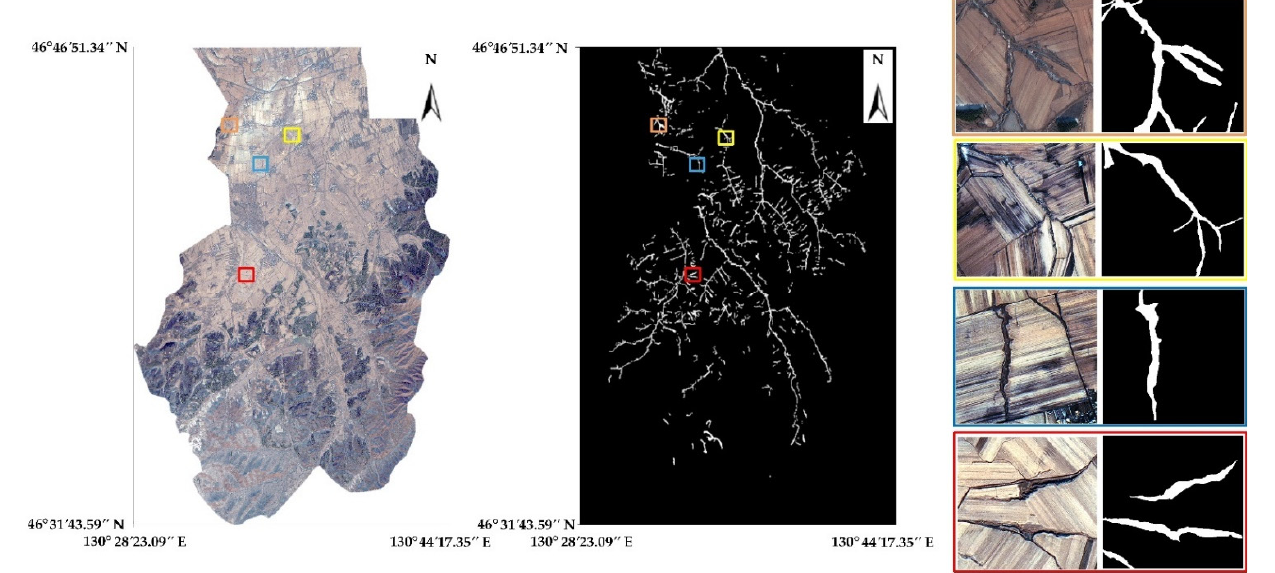
Figure 7. The latest monitoring data of Experiment 1 and corresponding labels. Among them, the colored rectangles are the representative lands, and the white as well as black pixels in the labels separately represent gully erosion and non-gully erosion.